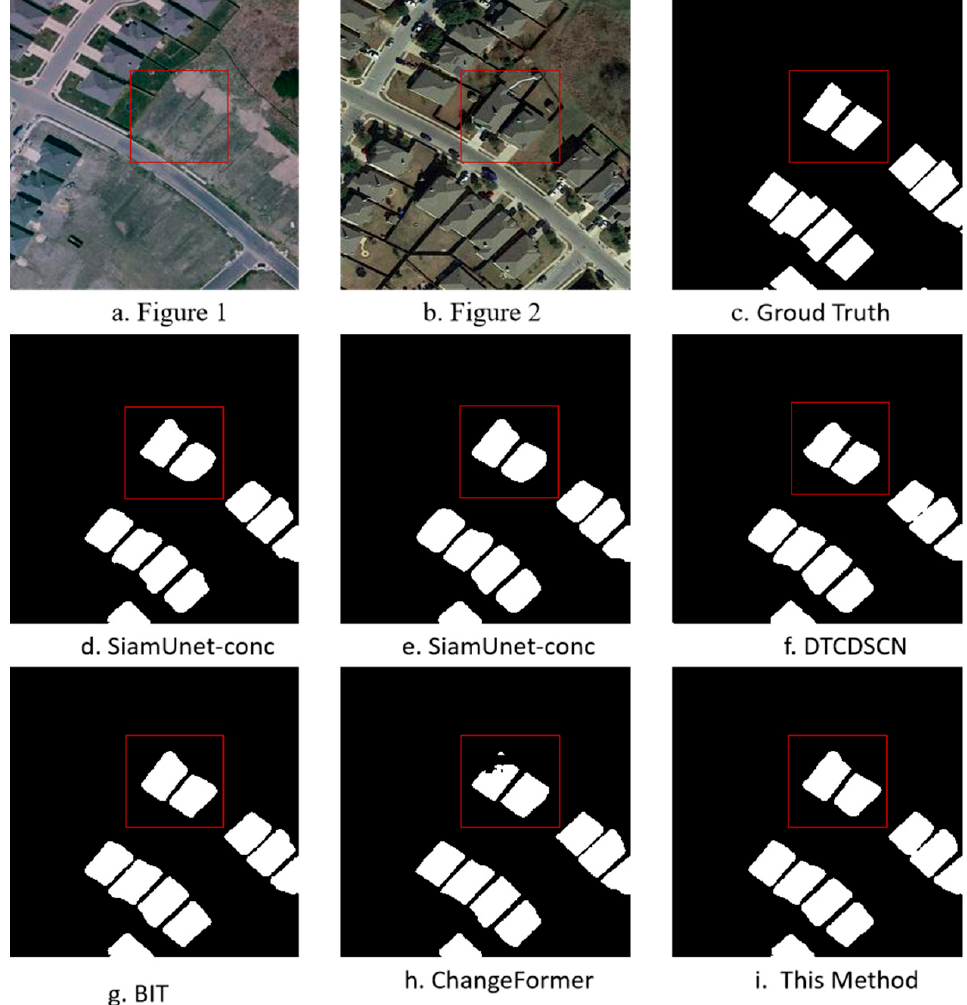
Figure 7. CD results under different methods (LEVIR_CD).